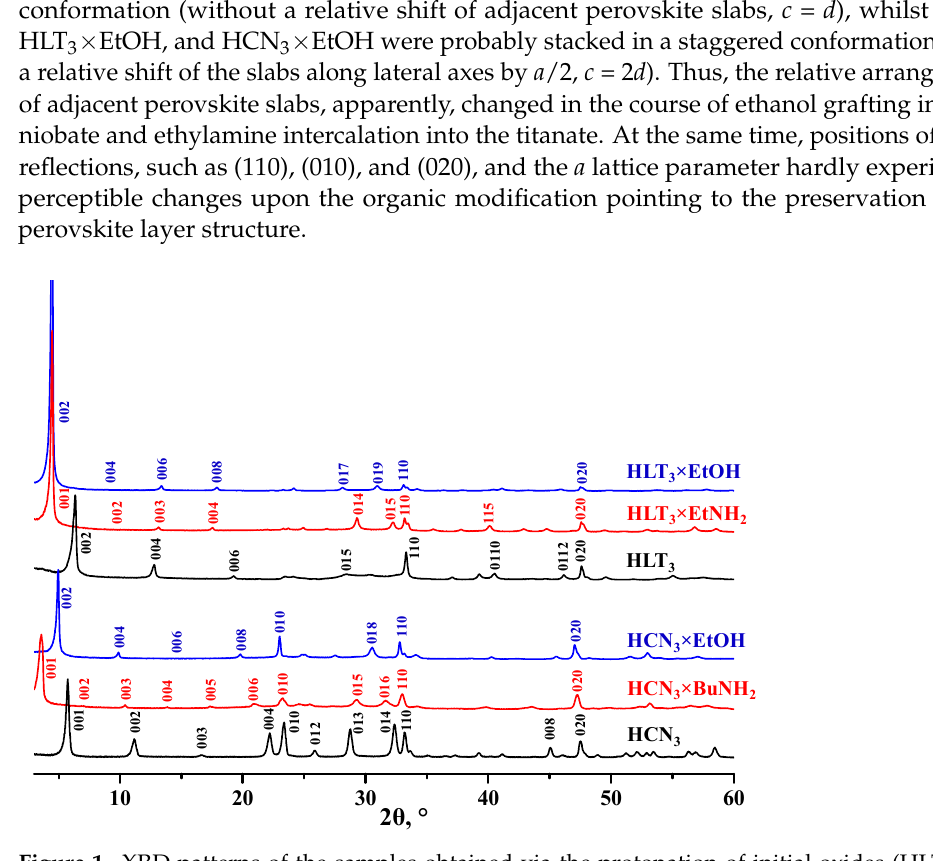
Figure 1. XRD patterns of the samples obtained via the protonation of initial oxides (HLT 3 and HCN 3 ), subsequent intercalation of amines (HCN 3 ×RNH 2 and HLT 3 ×RNH 2 ), and grafting of alcohols (HCN 3 ×ROH and HLT 3 ×ROH). Table 2. Lattice parameters in the tetragonal system, interlayer distances d , quantitative compositions (interlayer organic x and water y content per formula unit), light absorption edge, and specific surface areas of the samples.